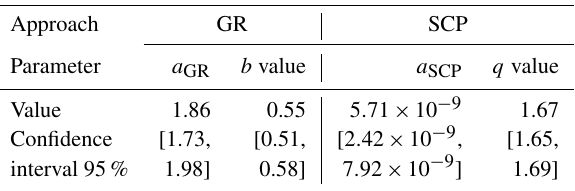
Table 1. Calculated seismicity parameters for the study area for GR and SCP.